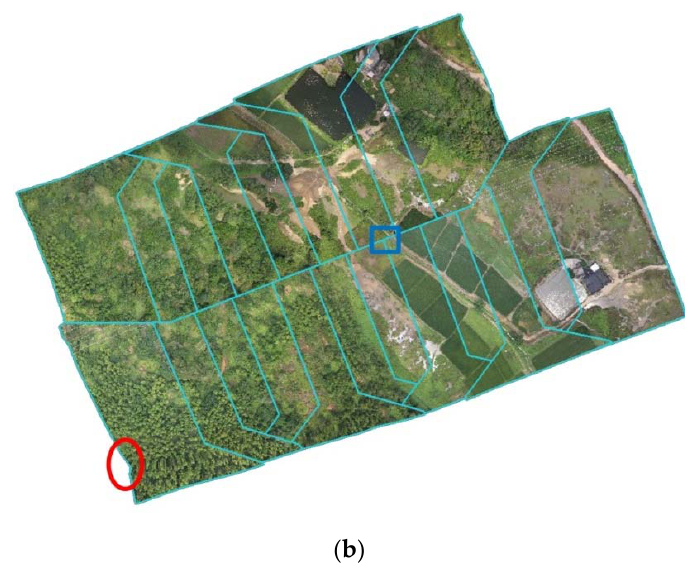
Figure 12. Results: ( a ) the generated seamline network overlapping the mosaic of Data Set 2 by Pan et al.’s (2014) method; ( b ) the generated seamline network overlapping the mosaic of Data Set 2 by Wan et al.’s (2013) method.